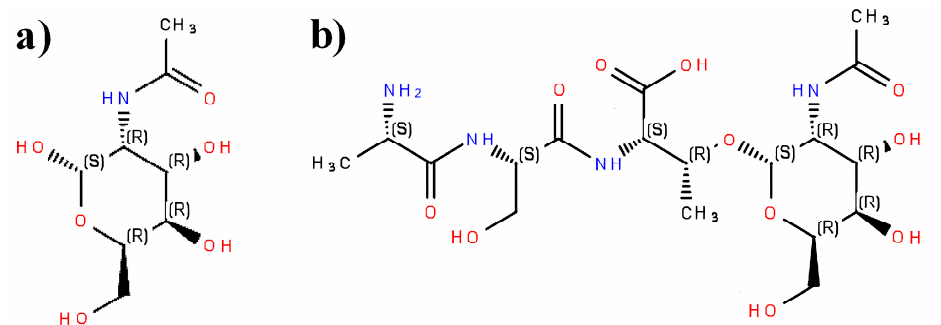
Figure 4. Structures of ( a ) N -Acetyl- α - D -galactosamine; ( b ) exemplary glycopeptide containing N -Acetyl- α - D -galactosamine residue with displayed absolute configuration of substituents around asymmetric carbon atoms. R—configuration Rectus; S—configuration Sinister. Structures displayed using Ketcher 2.0 program.